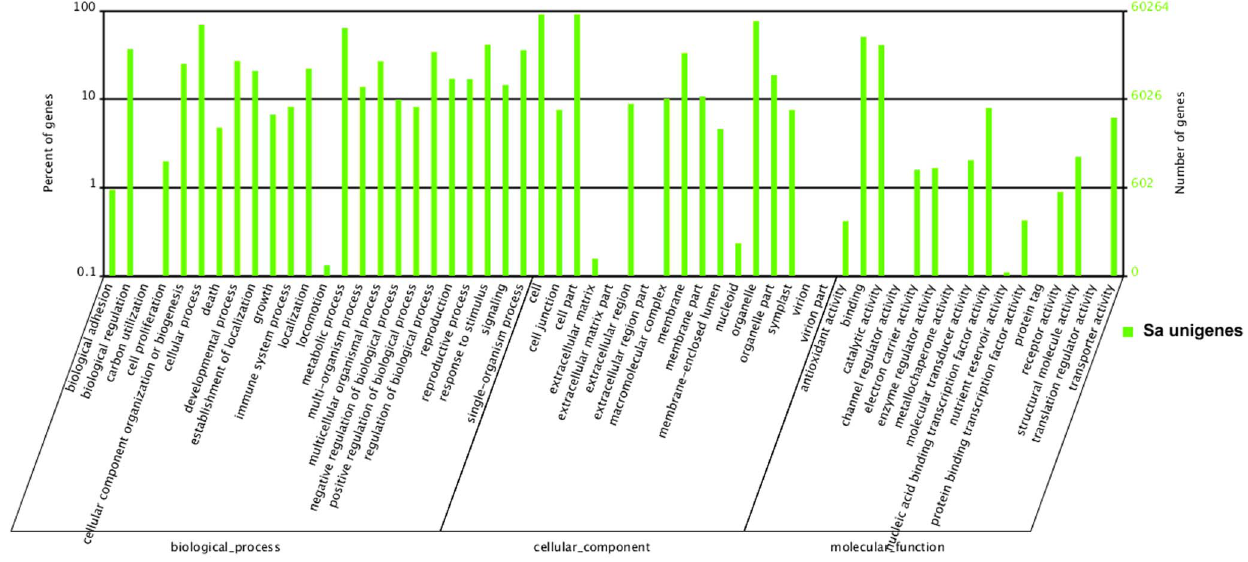
Figure 2. Gene Ontology (GO) analysis of transcriptome associated with flower development of S.arvensis . (The percentage and distribution of top-level GO-terms were portrayed in the three categories: Biological process, Cellular component and Molecular function.). Gene Ontology classifications of assembled unigenes, and 76,324 unigenes with significant similarity in Nr protein databases were assigned to gene ontology